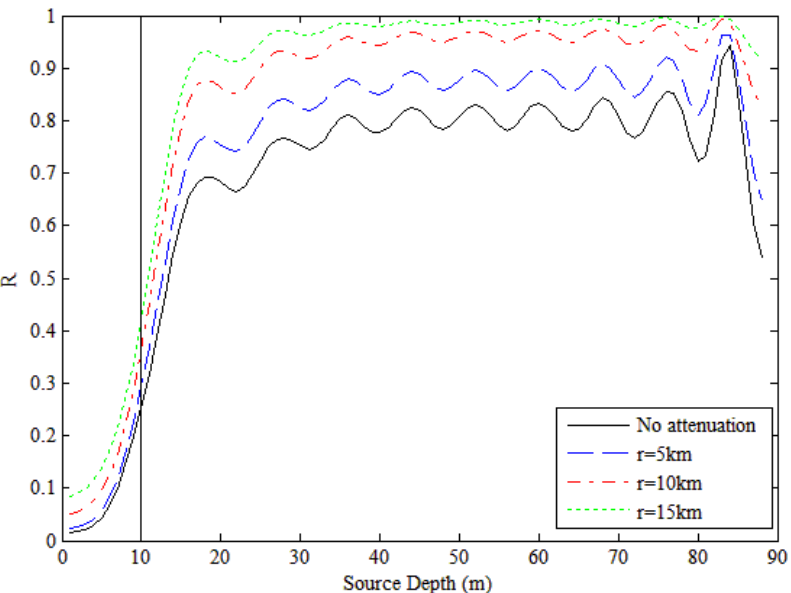
Figure 4. Evolution of power percentage (PP) of low order modes with source depth in shallow water waveguide for different source ranges. The vertical line indicates the discrimination depth z 0 chosen in Section 5.